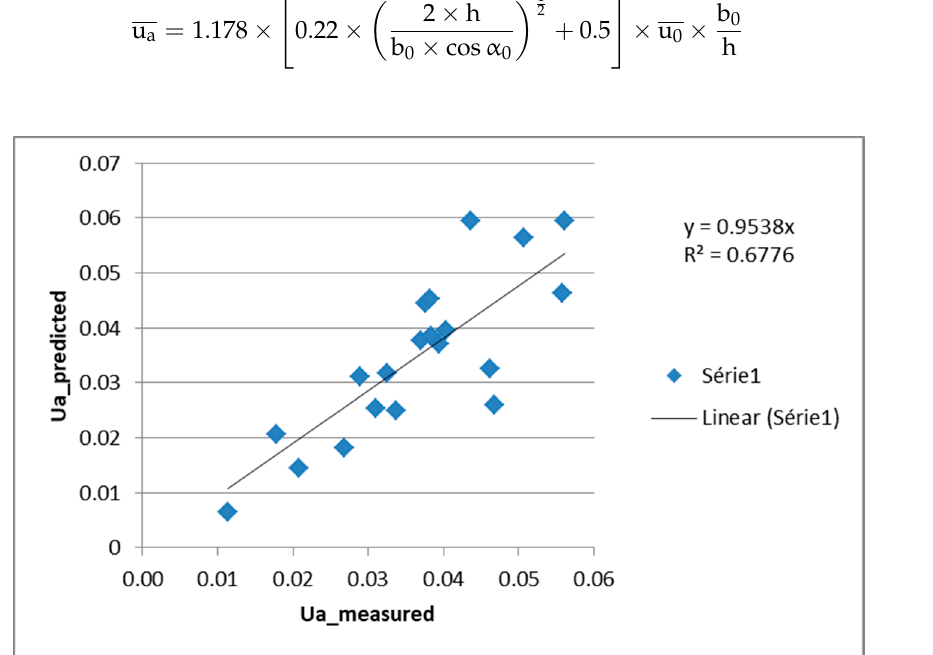
Figure 17. Comparison of the test results of u (cid:2911) (cid:3364)(cid:3364)(cid:3364) with the prediction of Equation (25).